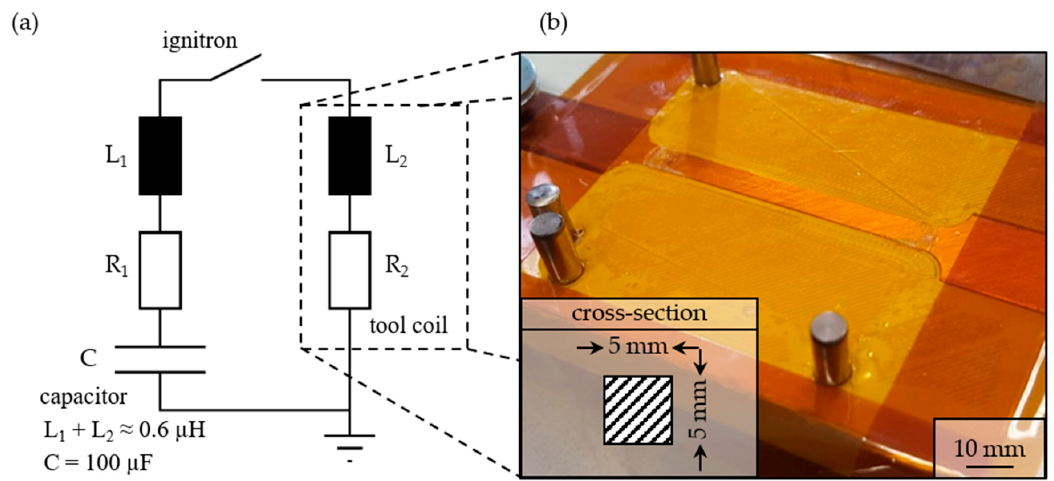
Figure 2. Experimental setup; ( a ) equivalent circuit diagram; ( b ) tool coil. Al99.5 sheets with a thickness of s 0 = 200 μ m dimensioned 50 × 50 mm 2 were used during the experiments. In combination with the single straight conductor coil and capacitor bank used in the tests, the skin depth in the aluminium sheet metal was 678 μ m. validation of the simulation results, four dies for free bulging were used, see Figure 3a.